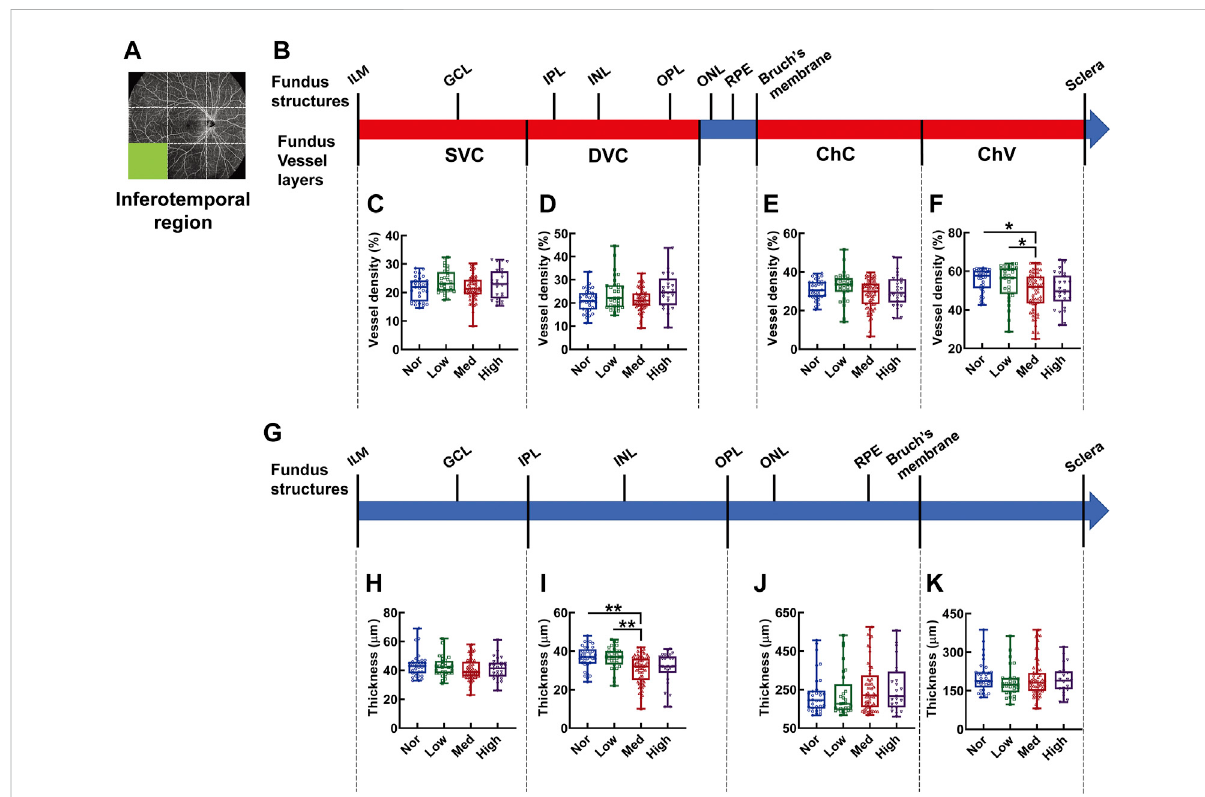
FIGURE 9 Vessellayerdensitiesandstructurethicknessesattheinferotemporalregionofthefundus.Positionoftheinferotemporalregionofthefundusis illustratedin (A) .Schematicillustrationofvessellayersinthefundusisshownin (B) .Vesseldensitiesofsuper fi cialvascularcomplex (C) ,deepvascular complex (D) , choriocapillary (E) , and choroidal vessel (F) layers are quanti fi ed and compared. Schematic illustration of segments in the fundus is shown in (G) . Thicknesses of the segments from IML to IPL (H) , from IPL to OPL (I) , from OPL to Bruch ’ s membrane (J) , and from Bruch ’ s membrane to the sclera (K) are quanti fi ed and compared. * p < 0.05, ** p < 0.01. SVC, super fi cial vascular complex; DVC, deep vascular complex; ChC, choriocapillary layer; ChV, choroidal vessel layer; NOR, normal group; Low, low-myopia group; Med, medium-myopia group; High, high myopia group; IML, inner limiting membrane; IPL, inner plexiform layer; and OPL, outer plexiform